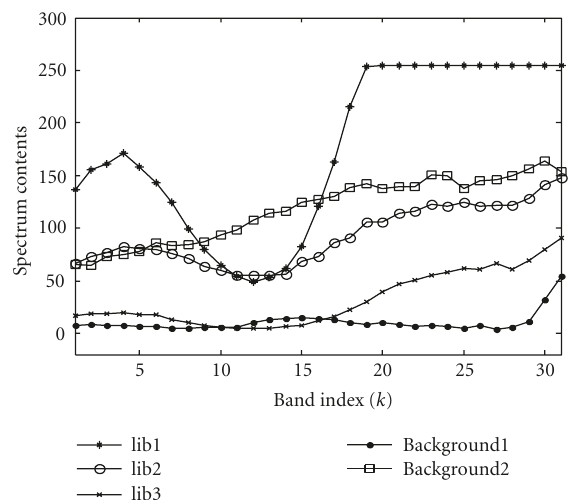
Figure 12: The comparison between spectrum of target libraries and the spectrum of the background of input bands.